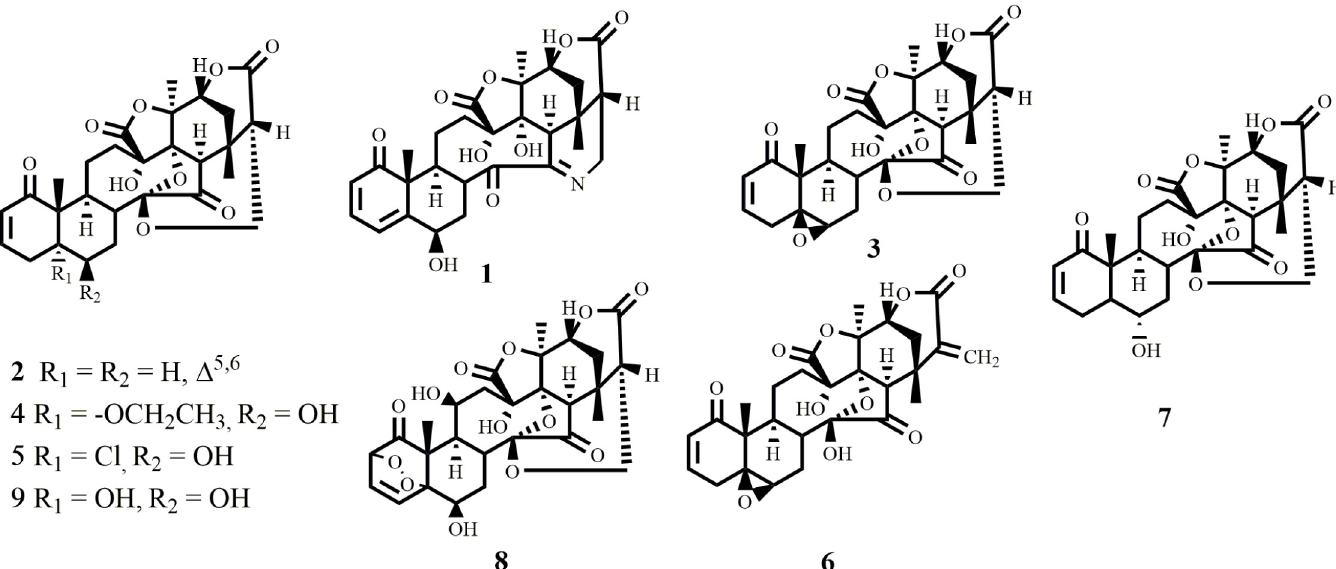
Fig 1. The structures of compounds 1–9 isolated from Physalis minima